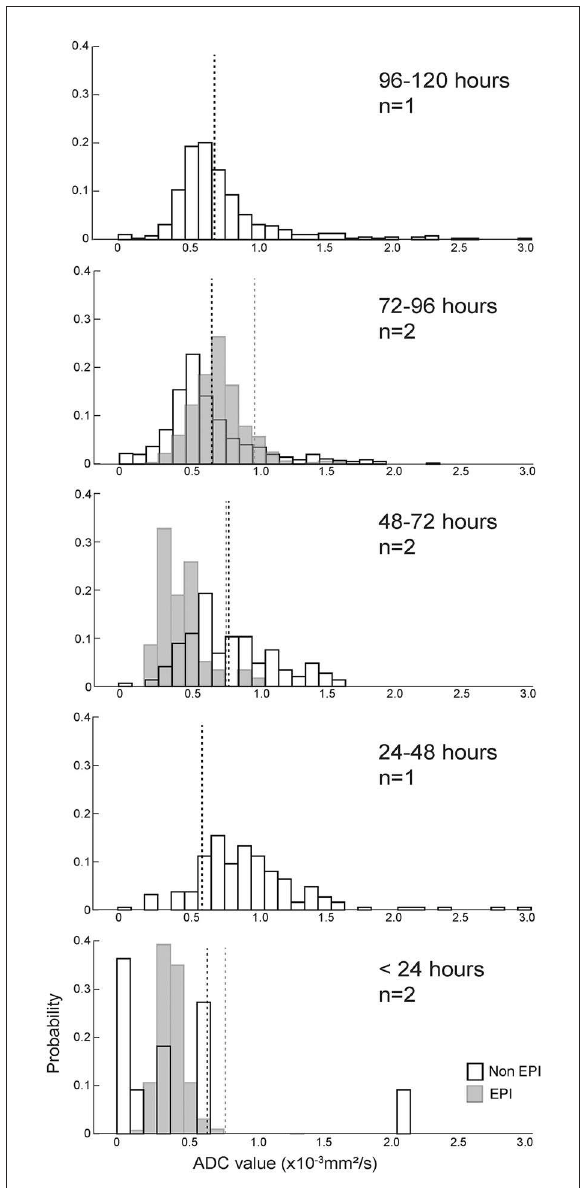
FIGURE4 ADC value histograms for eight ischemic CVAs, arranged by duration of clinical signs (more recent events below older events). Black outline bars indicate non-EPI DWI, and light gray bars indicate EPI DWI. The dotted lines show median ADC values for the control regions for each histogram, with black dotted lines corresponding to non-EPI DWI, and gray dotted lines corresponding to EPI DWI. Median absolute and relative ADC values for the T2-FLAIR ROIs, median absolute ADC values for the contralateral control regions, and anatomical locations of the lesions/control selections are listed in Table 1. For most cases, the ROIs had median absolute ADC values < 1.0x10 − 3 mm 2 /s and median relative ADC values < 1. The CVAs with the shortest duration had the lowest ADC